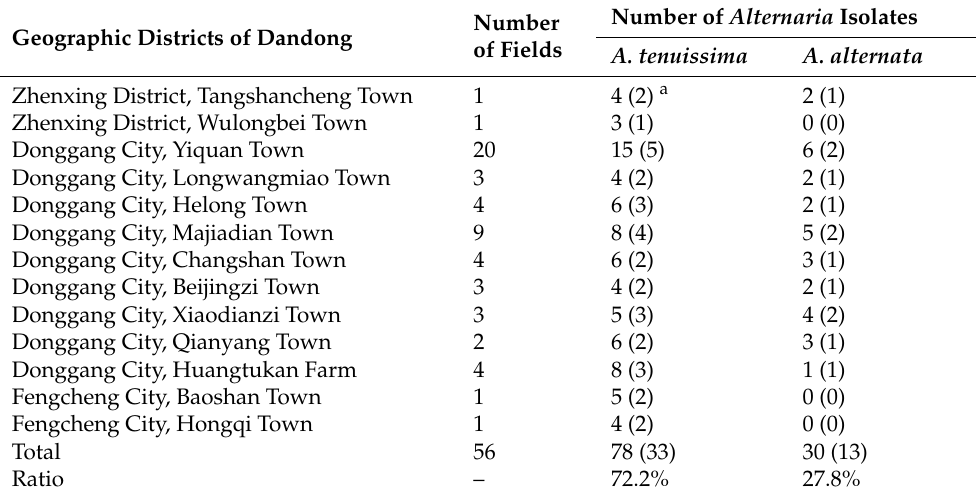
Table 1. Geographic origins and numbers of Alternaria isolates derived from strawberry leaves with typical features of black spot disease in Dandong, Liaoning province, China. Geographic Districts of Dandong